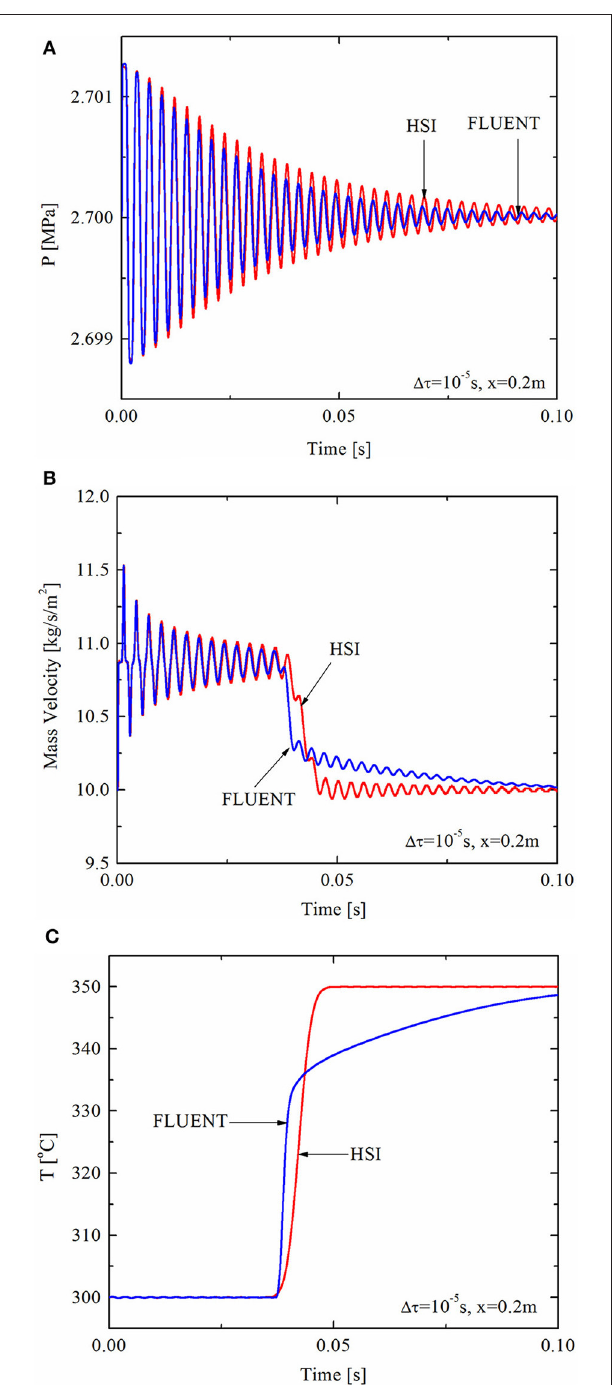
FIGURE 12 | Comparisons of the HSI method and FLUENT under inlet temperature transient. (A) Pressure responses. (B) Mass velocity responses. (C) Temperature